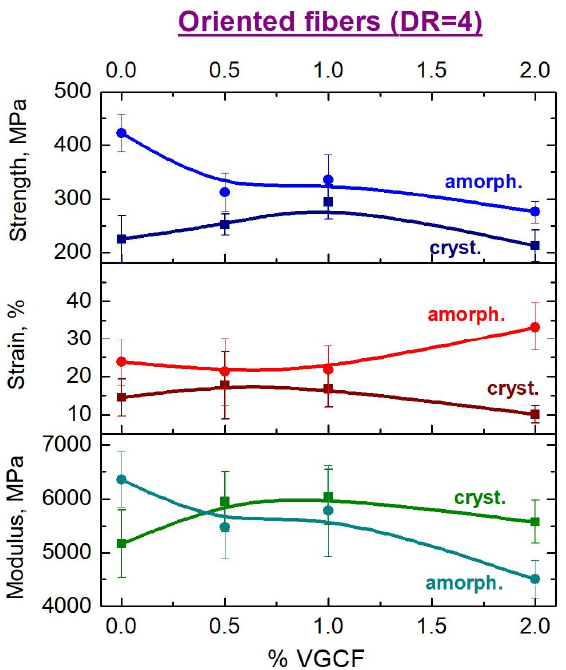
Figure 15. Dependences of the mechanical properties on the concentration of the VGCF nanoparticles in the R-BAPB polyimide matrix for the amorphous and crystallized fibers after orientational drawing (DR = 4).